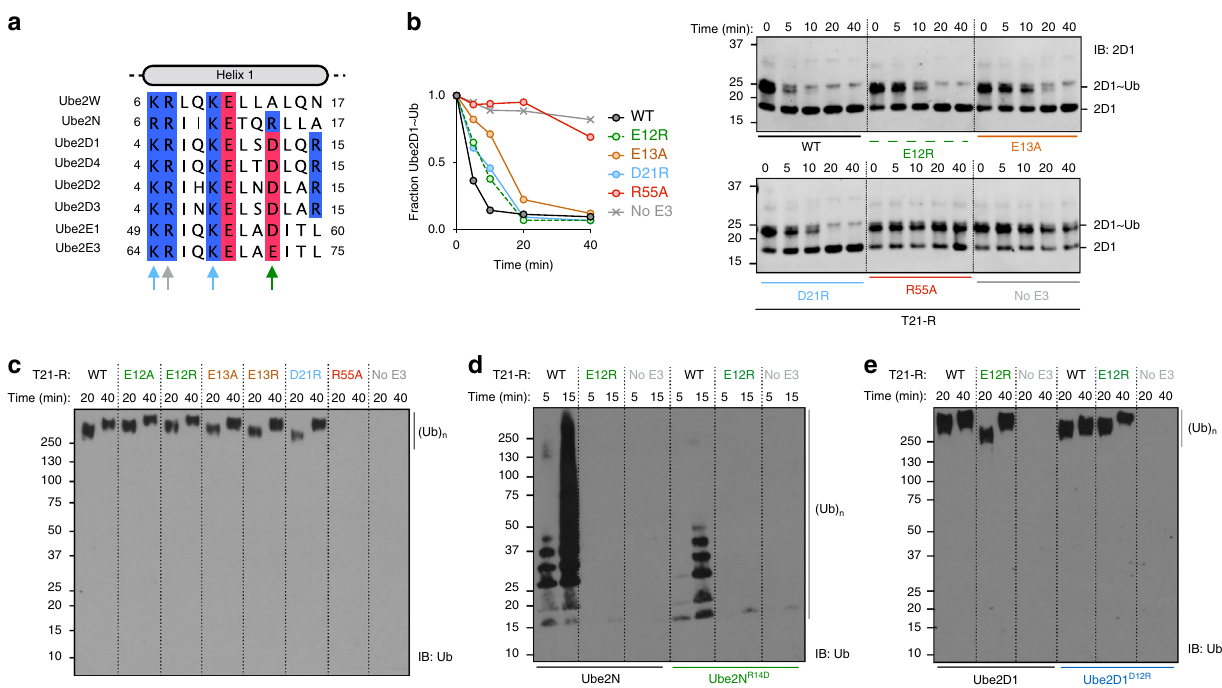
Fig. 5 Ionic anchor points enable TRIM21 with a Ube2N-speci fi c catalytic mechanism. a Clustal omega sequence alignment of all positive hits of the E2 screen (Fig. 1a). Arrows mark residues involved in RING interactions in our T21-R Ube2N~Ub structure. Lysine and arginine residues are colored in blue, aspartate and glutamate residues in red. The full alignment of all E2 enzymes used in the E2 screen (Fig. 1a) is shown in Supplementary Fig. 9. b Catalysis of ubiquitin discharge from pre-charged Ube2D1~Ub, and c catalysis of unanchored ubiquitin chains by Ube2D1 of T21-R anchor point mutants. Catalysis of ubiquitin chains by d Ube2N WT and R14D mutant and e Ube2D1 WT and D12R mutant. All biochemical assays were performed in at least two independent experiments. Source data are provided as a Source Data fi